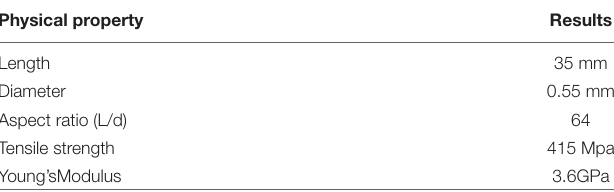
TABLE 2 | Physical property of steel fibers.